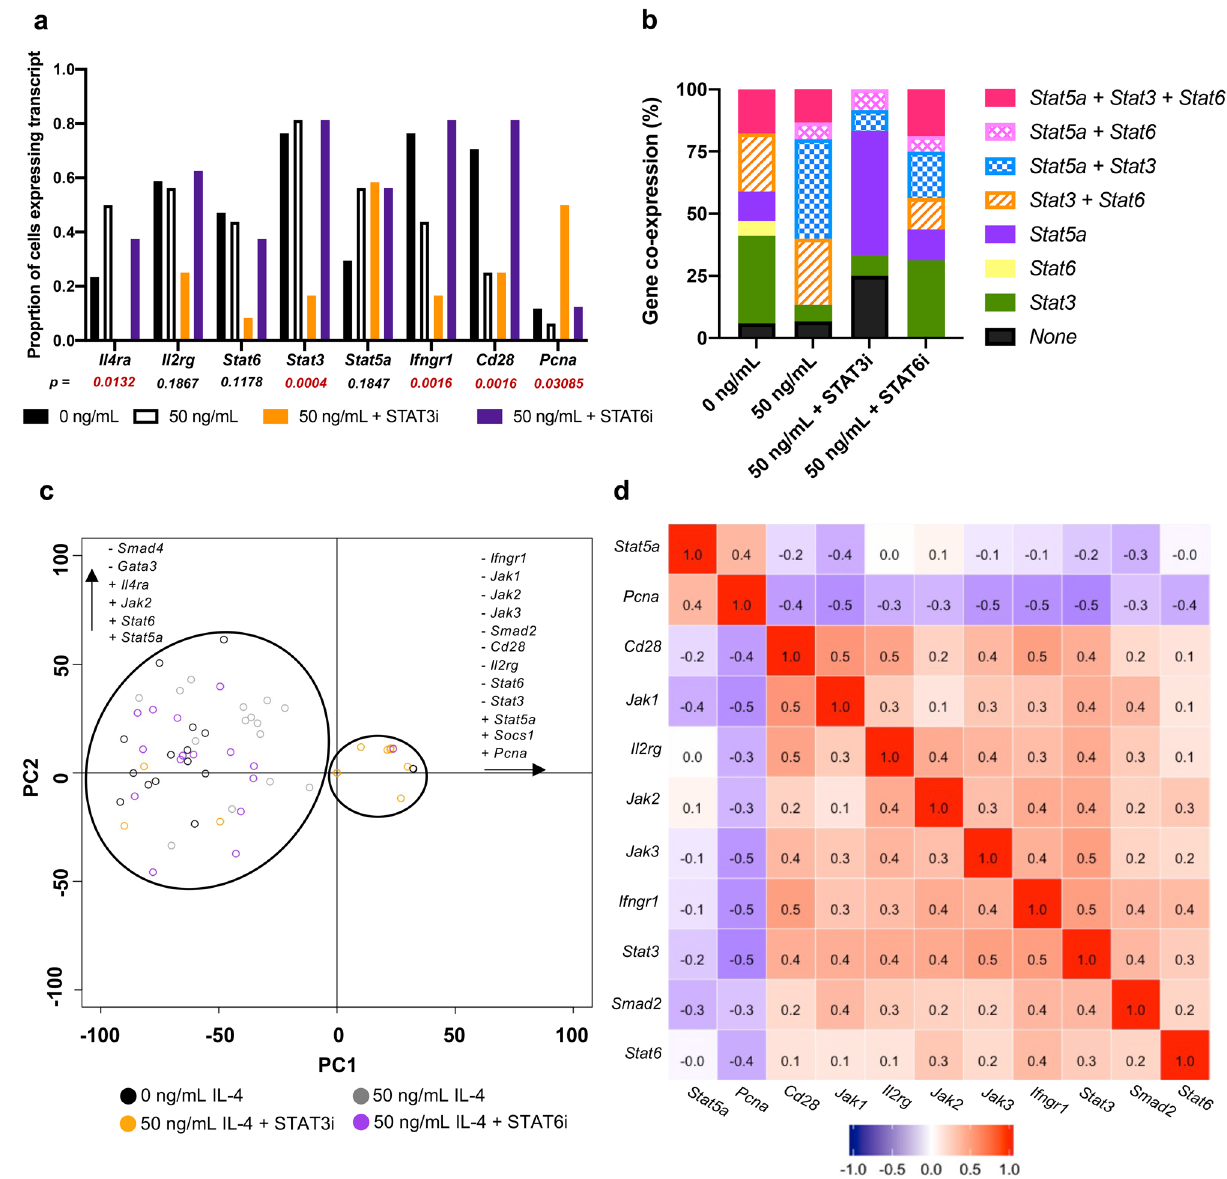
Figure 6. Expression of IL-4/IL-13-associated genes requires STAT3 availability. Whole spleen homogenate derived from naïve 6–8-week-old female BALB/c mice were pre-incubated with STAT3i or STAT6i in vitro for 3 h prior to stimulation with 50 ng/mL IL-4 for 24 h. Fluidigm Biomark 48.48 analyses were performed on single CD3 + CD4 + CD8 - IL-4R ⍺ + cells, evaluating transcript expression of genes-of-interest. (a) dichotimised gene expression profiles of genes-of-interest between treatments. Statistical significance was determined by performing a Fisher’s exact test. ( b ) Co-expression analysis of members of the STAT family (STAT6, STAT3 and STAT5a). (c) PCA was conducted to evaluate heterogeneity in transcriptional profiles, particularly whether the heterogeneity can be explained by the treatment (refer Sup. Fig. 7a,b for loadings). (d) For genes expressed by at least 15% of cells, Spearman’s rank correlation analysis was performed to evaluate correspondence of genes pairwise. According to the similarity in transcriptional profiles, a major cluster of positively correlated genes were identified and highlighted, along with a negatively correlated cluster (refer Sup. Fig. 7a for dendrogram). The experiment was repeated twice, pooling the data. n ~ 15 cells per